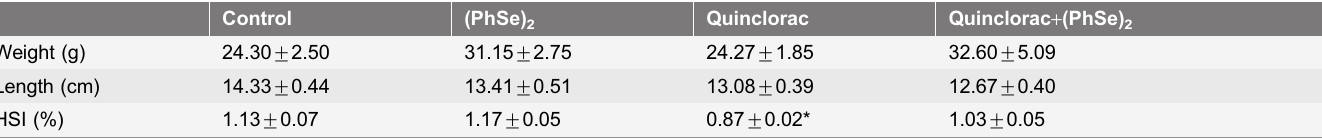
Table 1. Growth parameters.